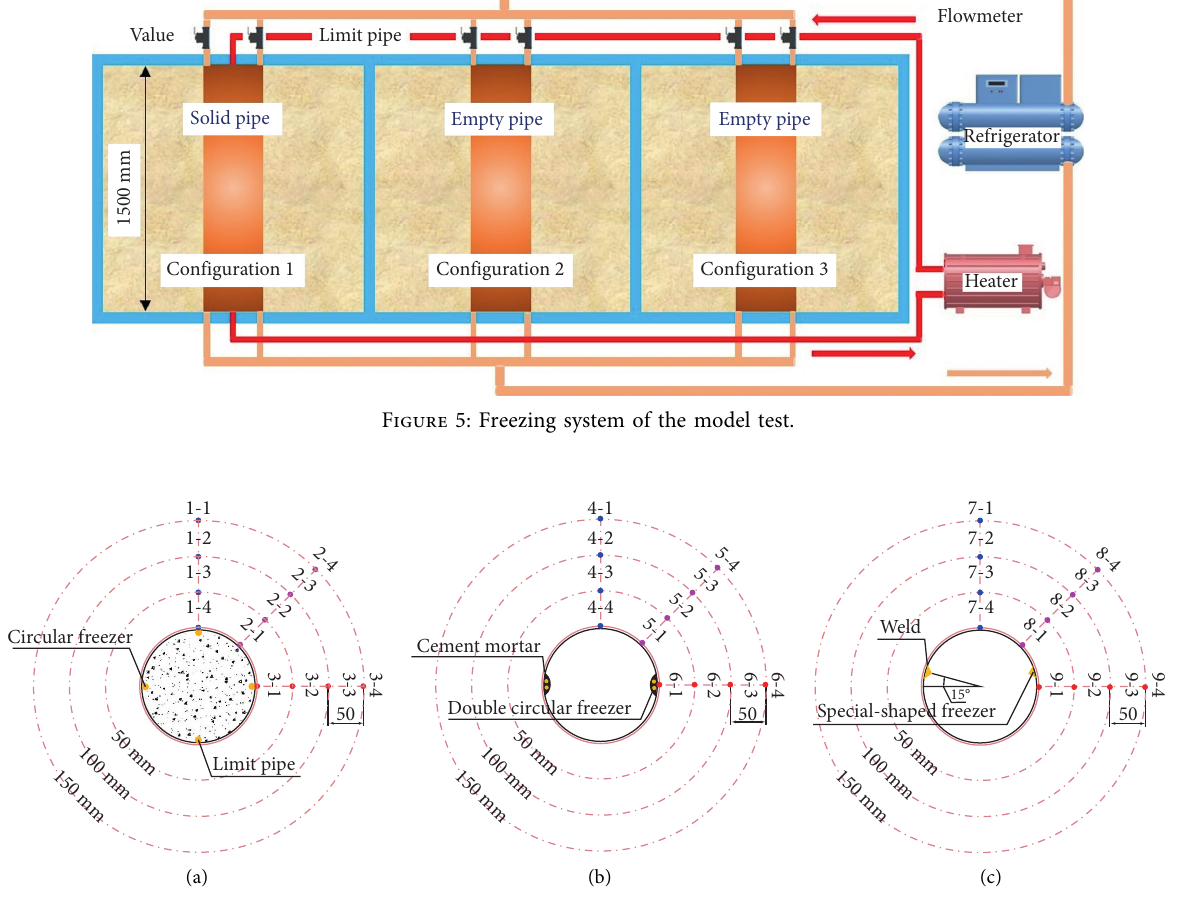
Figure 6: Arrangement of temperature monitoring points: (a) SCF; (b) EDCF; (c) ESF.